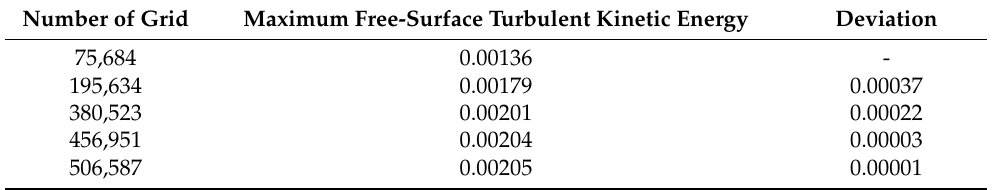
Table 2. Grid sensitivity analysis.